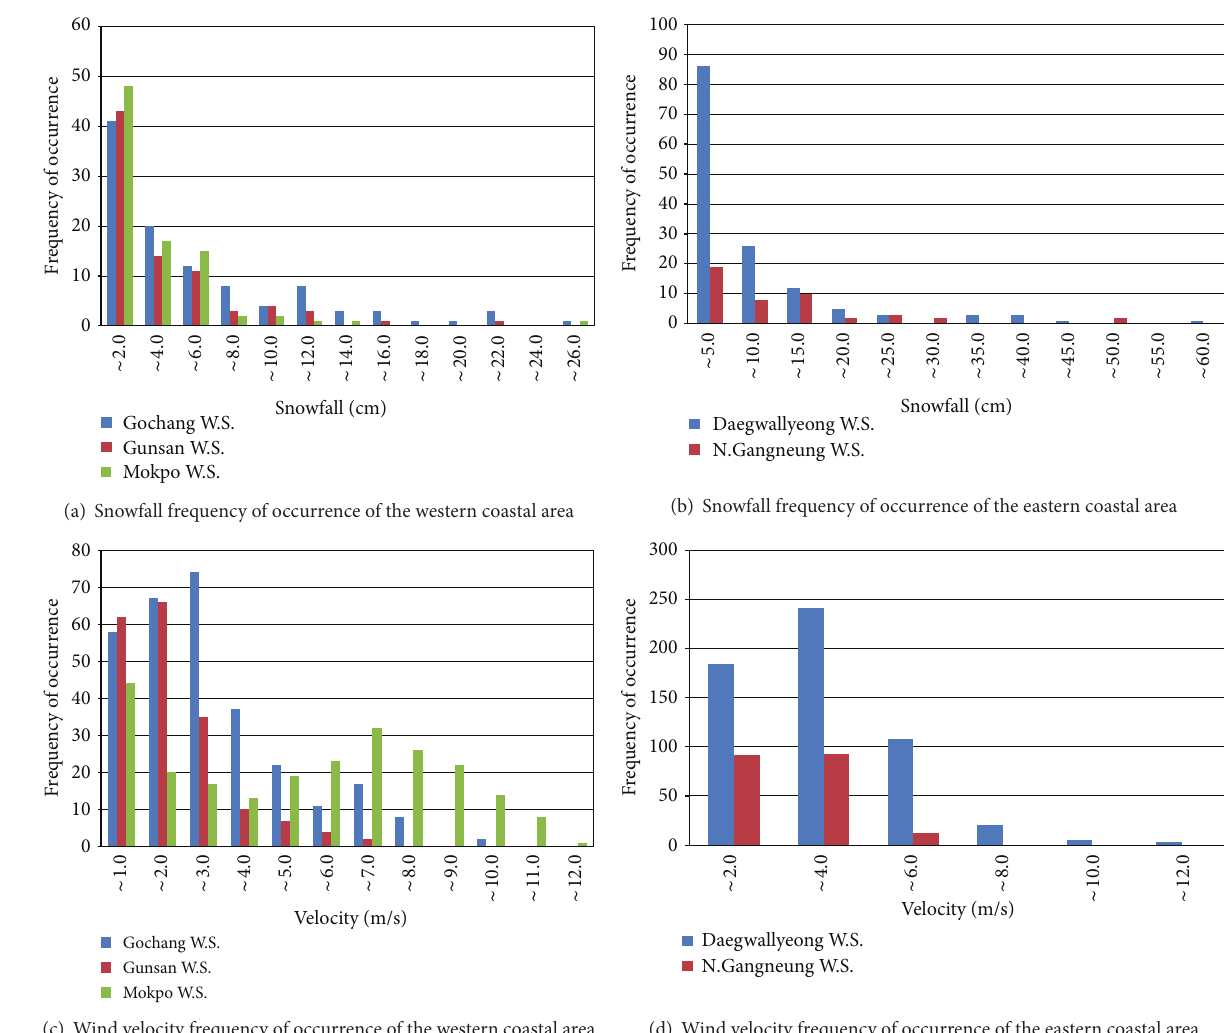
Figure 2: Snowfall frequency of occurrence and wind velocity frequency of occurrence.